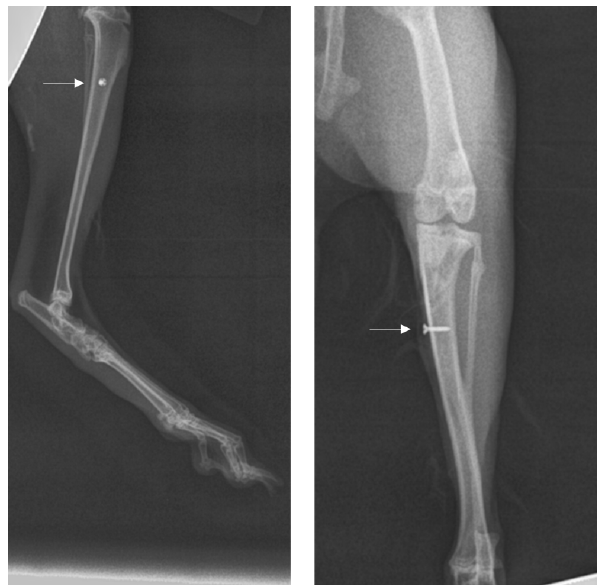
Figure 3. Medial and supine X-rays of the left rabbit tibia to show implant placement